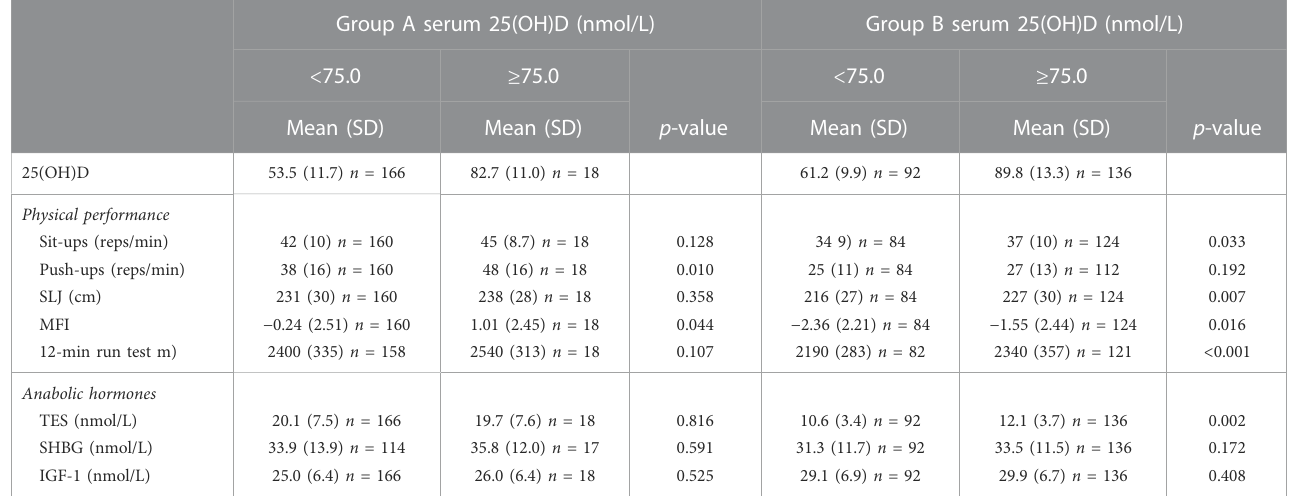
TABLE3Differencesofthemean(±SD)anabolichormonelevelsandphysicalperformancetestresultsbetweenthesubgroupsdividedbysuf fi cientlevel(75 nmol/L)of serum 25 (OH) D in group A (data gathered in January) and B (data gathered in July). Standing long jump (SLJ); muscular fi tness index (MFI); testosterone (TES); sex hormone binding globulin (SHBG); testosterone-sex hormone binding globulin ratio (TES/SHBG); insulin-like globulin factor-1 (IGF-1). Differences between groups were tested using Independent Samples t